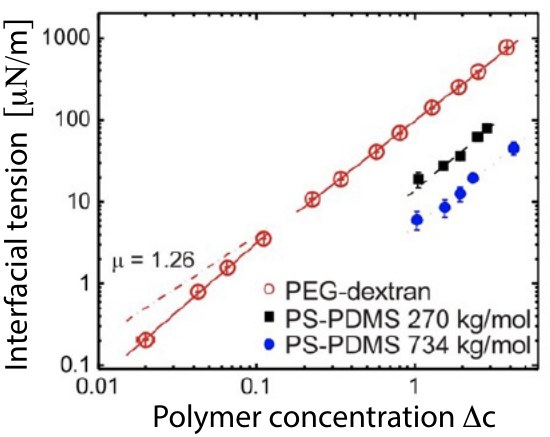
Figure 5. Interfacial tension Σ αβ of the liquid–liquid interface between the PEG-rich phase α and the dextran-rich phase β as a function of the polymer concentration ∆ c ≡ ( c − c cr ) / c cr where c cr denotes the concentration at the critical demixing point [16]. The red data for the PEG-dextran solutions exhibit the power-law behavior Σ αβ ∼ ∆ c µ where the critical exponent µ is close to the mean value µ = 3/2. For comparison, the dashed red line corresponds to µ = 1.26 based on the hyperscaling relation µ = 2 ν [49] where ν is the critical exponent of the correlation length. (With permission from